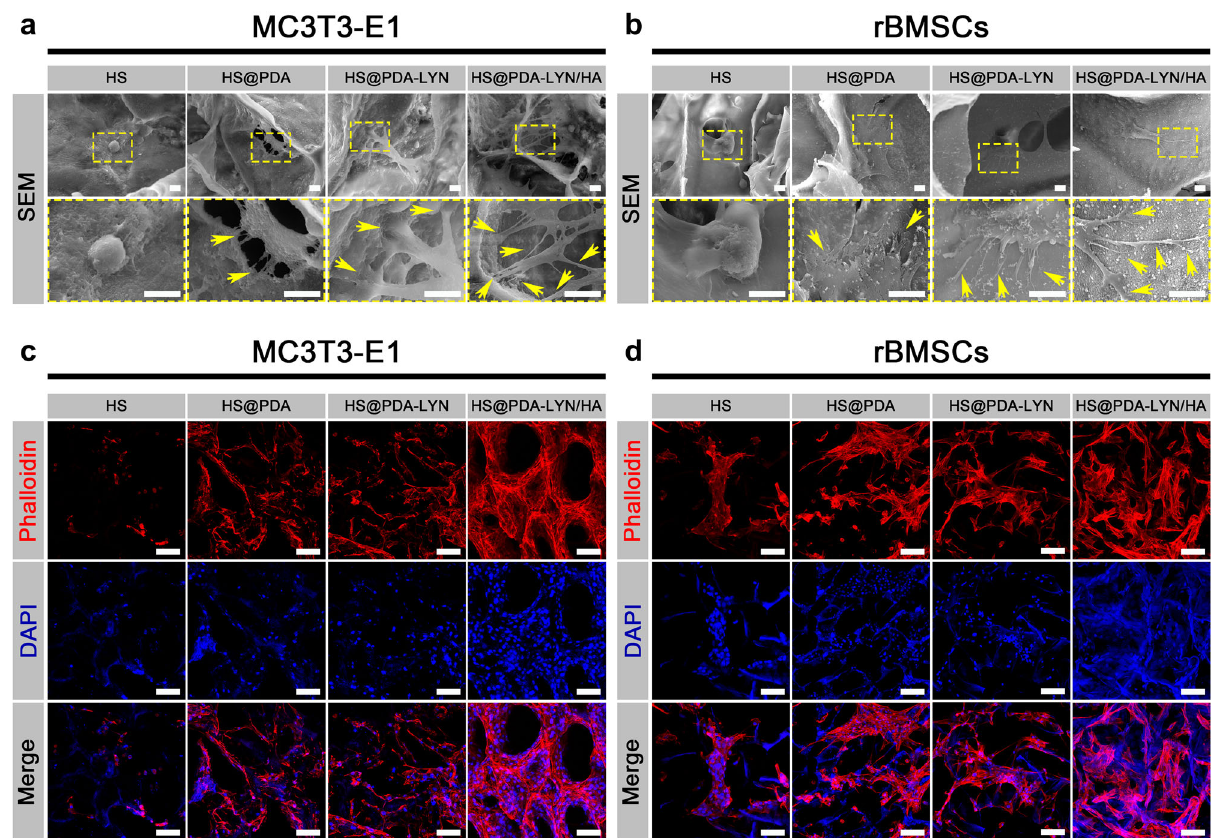
Fig. 4 Cell adhesion, spreading and morphology on different samples. Representative SEM images of a MC3T3-E1 cells and b rBMSCs cultured on different scaffolds after 7 days. Representative confocal fl uorescence images of F-actin (red) and nuclei (blue) in c MC3T3-E1 cells and d rBMSCs cultured on different scaffolds after 7 days. The yellow arrows indicate fi lopodia of cells adhered to scaffold surfaces. Scale bar in a , b : 10 μ m, in c , d : 100 μ